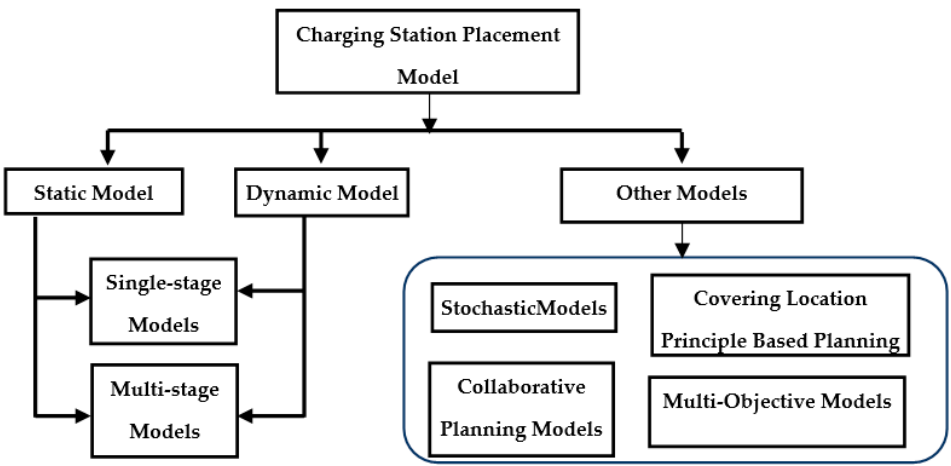
Figure 2. CS placement problem classification.